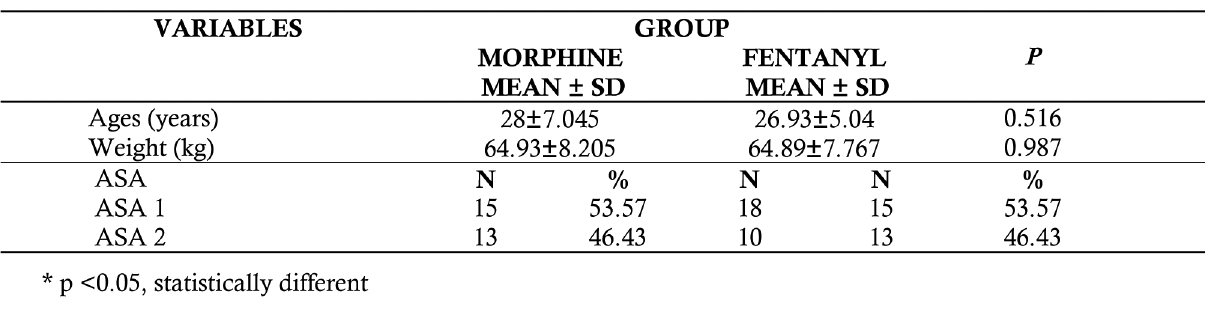
Comparison in Efficacy between Fentanyl Continuous Infusion and Intrathecal Morphine... Table 1. Baseline data on age, body weight and physical status of preoperative ASA